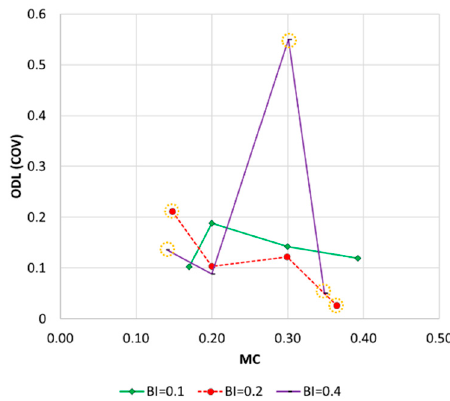
Figure 11. ODLs and MCs of the 12 networks grouped by BI values (C network). Note that the dashed circles indicate the case including infeasible solution(s).